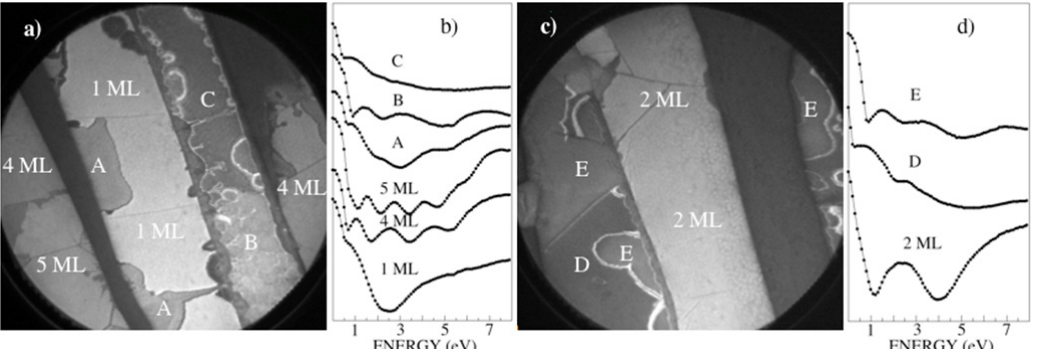
Figure 1. Low Energy Electron Microscopy (LEEM) images collected at a field of view (FOV) of 25 μ m from a C-face sample using an energy of ( a ) 3.9 eV and from another position ( c ) at an energy of 5.1 eV. The electron reflectivity curves in ( b ) and ( d ), extracted from different locations in ( a ) and ( c ), reveal fairly large areas of 1, 4 and 5 MLs and of 2 MLs of graphene,